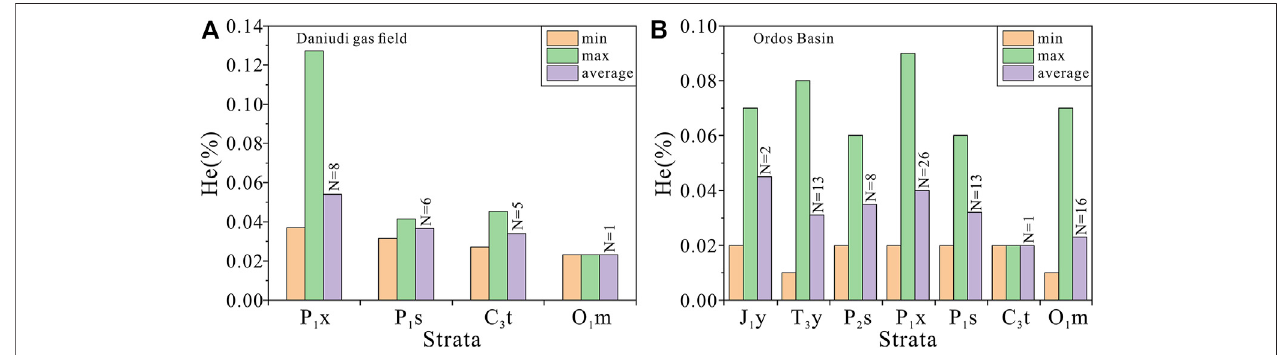
FIGURE 3 | Distribution of helium concentrations in natural gas from different strata in the Daniudi gas fi eld (A) and Ordos Basin (B) . The data in (B) are from Dai et al . (2017).